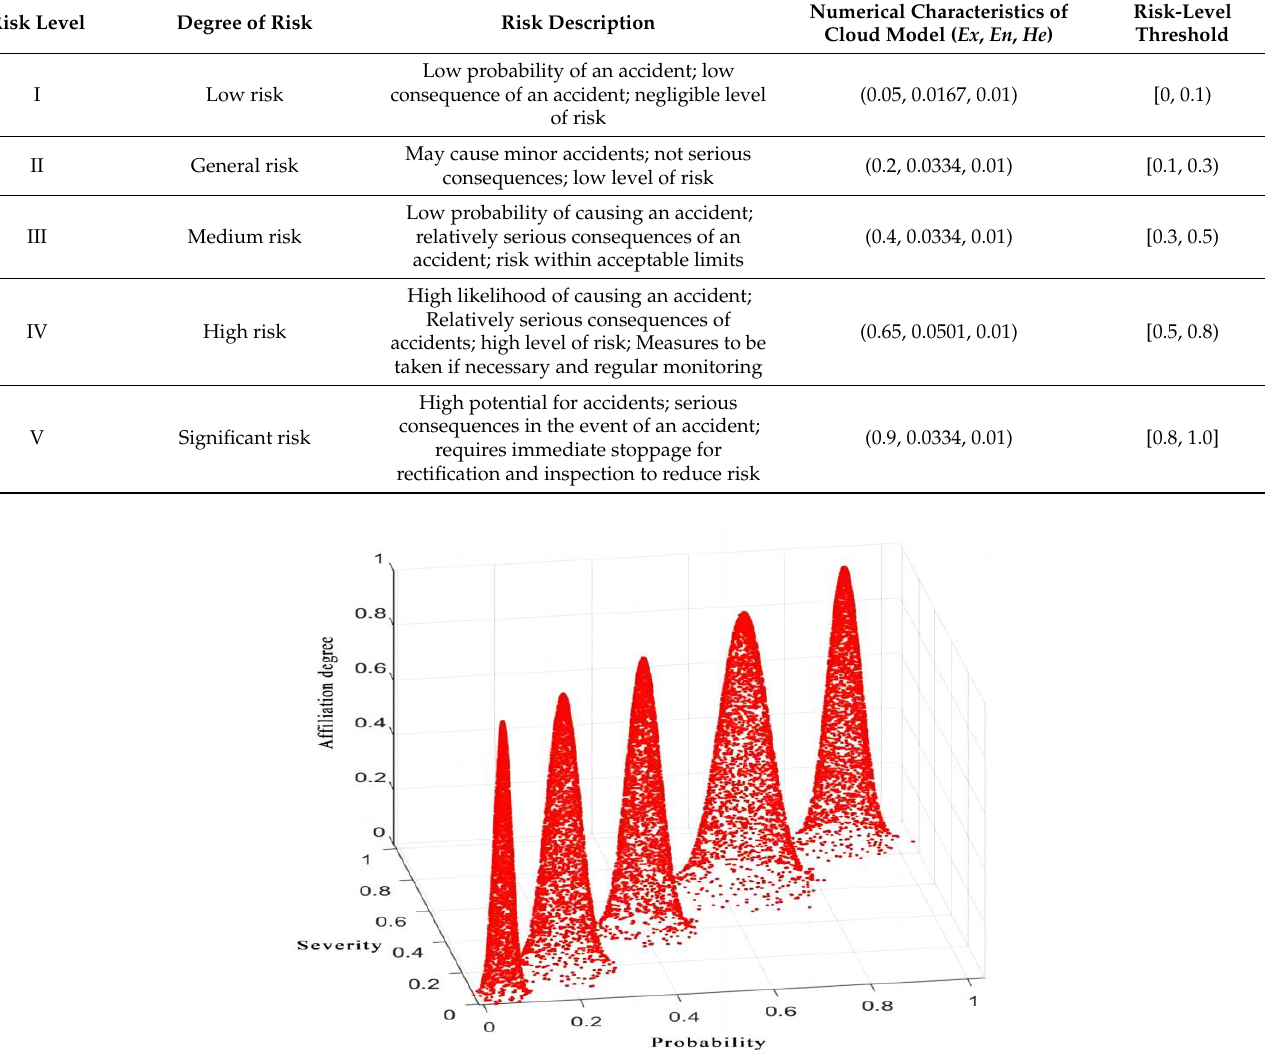
Figure 10. LNG storage tank leakage accident risk level standard cloud.